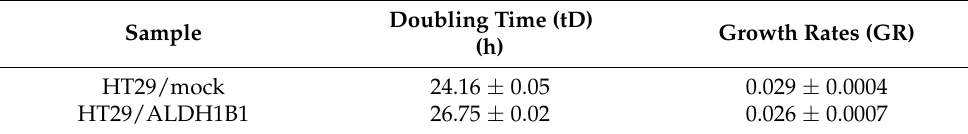
Figure 3. Expression of ALDH1B1 decreases the cell proliferation rate and clonogenic efficiency in HT29 cells. ( a ) Growth rates of HT29/mock and HT29/ALDH1B1 cells. Cells were plated at a density of 4 × 10 5 cells/plate in 10-cm culture plates, and the total number of cells was determined every 24 h over 3 consecutive days. ( b ) Confluency of HT29/ALDH1B1 cells versus HT29/mock cells at 72 h post-seeding. Cells were seeded at a density of 4 × 10 3 cells/well in 96-well plates, grown for 72 h and processed for fixation and staining by the sulforhodamine B (SRB) assay. Absorbance was measured at 570 nm, and the cell viability percentage (%) was calculated and normalized relative to the control (HT29/mock) cells. ( c ) Representative plates of colony formation efficiency of HT29/mock and HT29/ALDH1B1 cells. Cells (1000) were seeded in 10-cm culture plates and observed for colony formation approximately 20 days following their plating. Then, cells were stained with crystal violet. ( d ) Quantitative assessment of colony formation efficiency. Results are expressed as mean ± SD of three independent experiments. * p < 0.05 and ** p < 0.01. Table 3. Doubling time (tD) and growth rates of the HT29 isogenic cell line